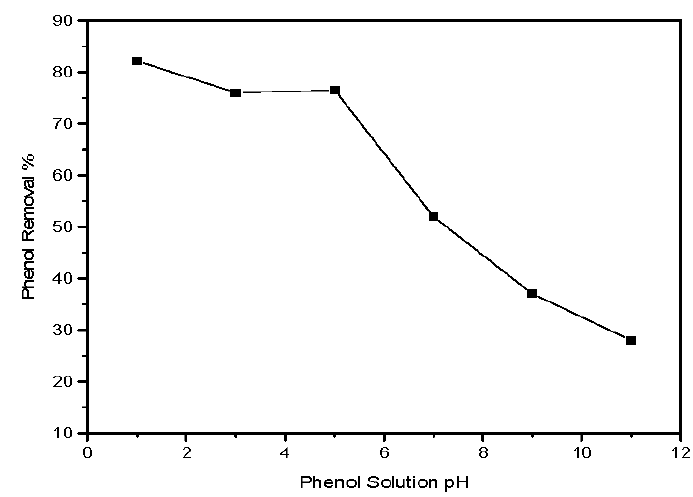
Figure 7. Influence of solution pH on the percentage of phenol removal on to magnetic ZnO nanotubes (initial phenol concentration = 10 ppm, material dosage = 2 g/L, agitation speed = 440 rpm, contact time = 90 min and temperature = 25 °C).